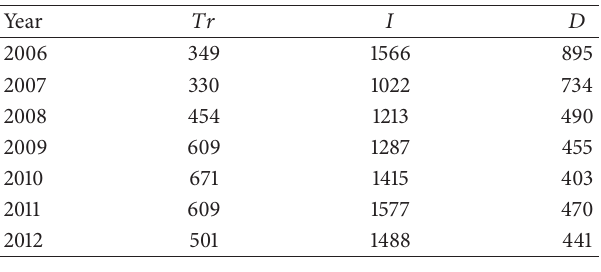
Table 2: Actual number of liver transplantations (2006–2012) ( 𝑇𝑟 ), the incidence of new patients on the list ( 𝐼 ), and the number of patients who died while being on the waiting list ( 𝐷 ), in the state of S˜ao Paulo from 2006 until 2012 (after MELD).